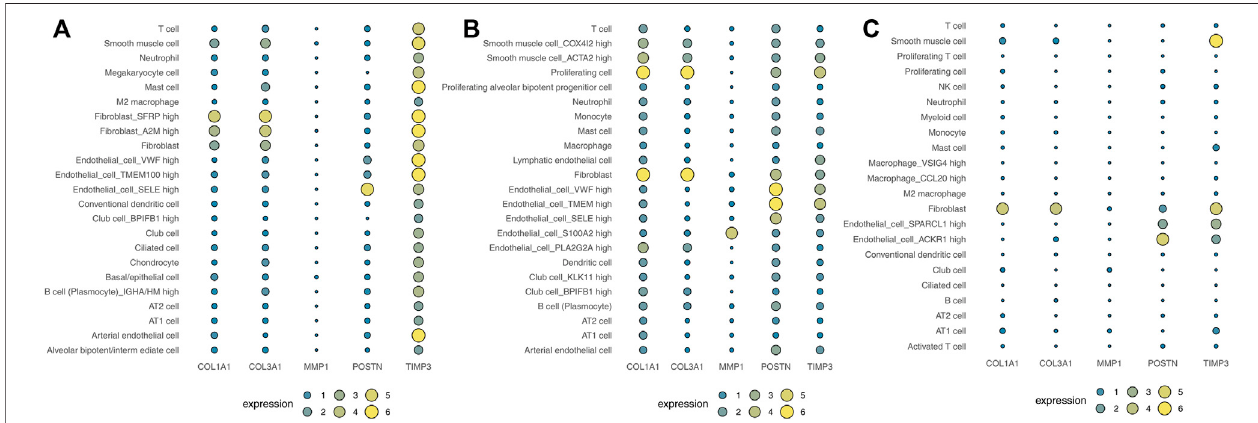
FIGURE 6 | Analysis of the expression landscape of the fi ve hub genes using Human cell landscape analysis. Notes: (A) : Single-cell analysis evaluating the expression of hub genes in Kidney1 based on the Human cell landscape data; (B) : Single-cell analysis evaluating the expression of hub genes in Kidney2 based on the Human cell landscape data; (C) : Single-cell analysis evaluating the expression of hub genes in Kidney3 based on the Human cell landscape